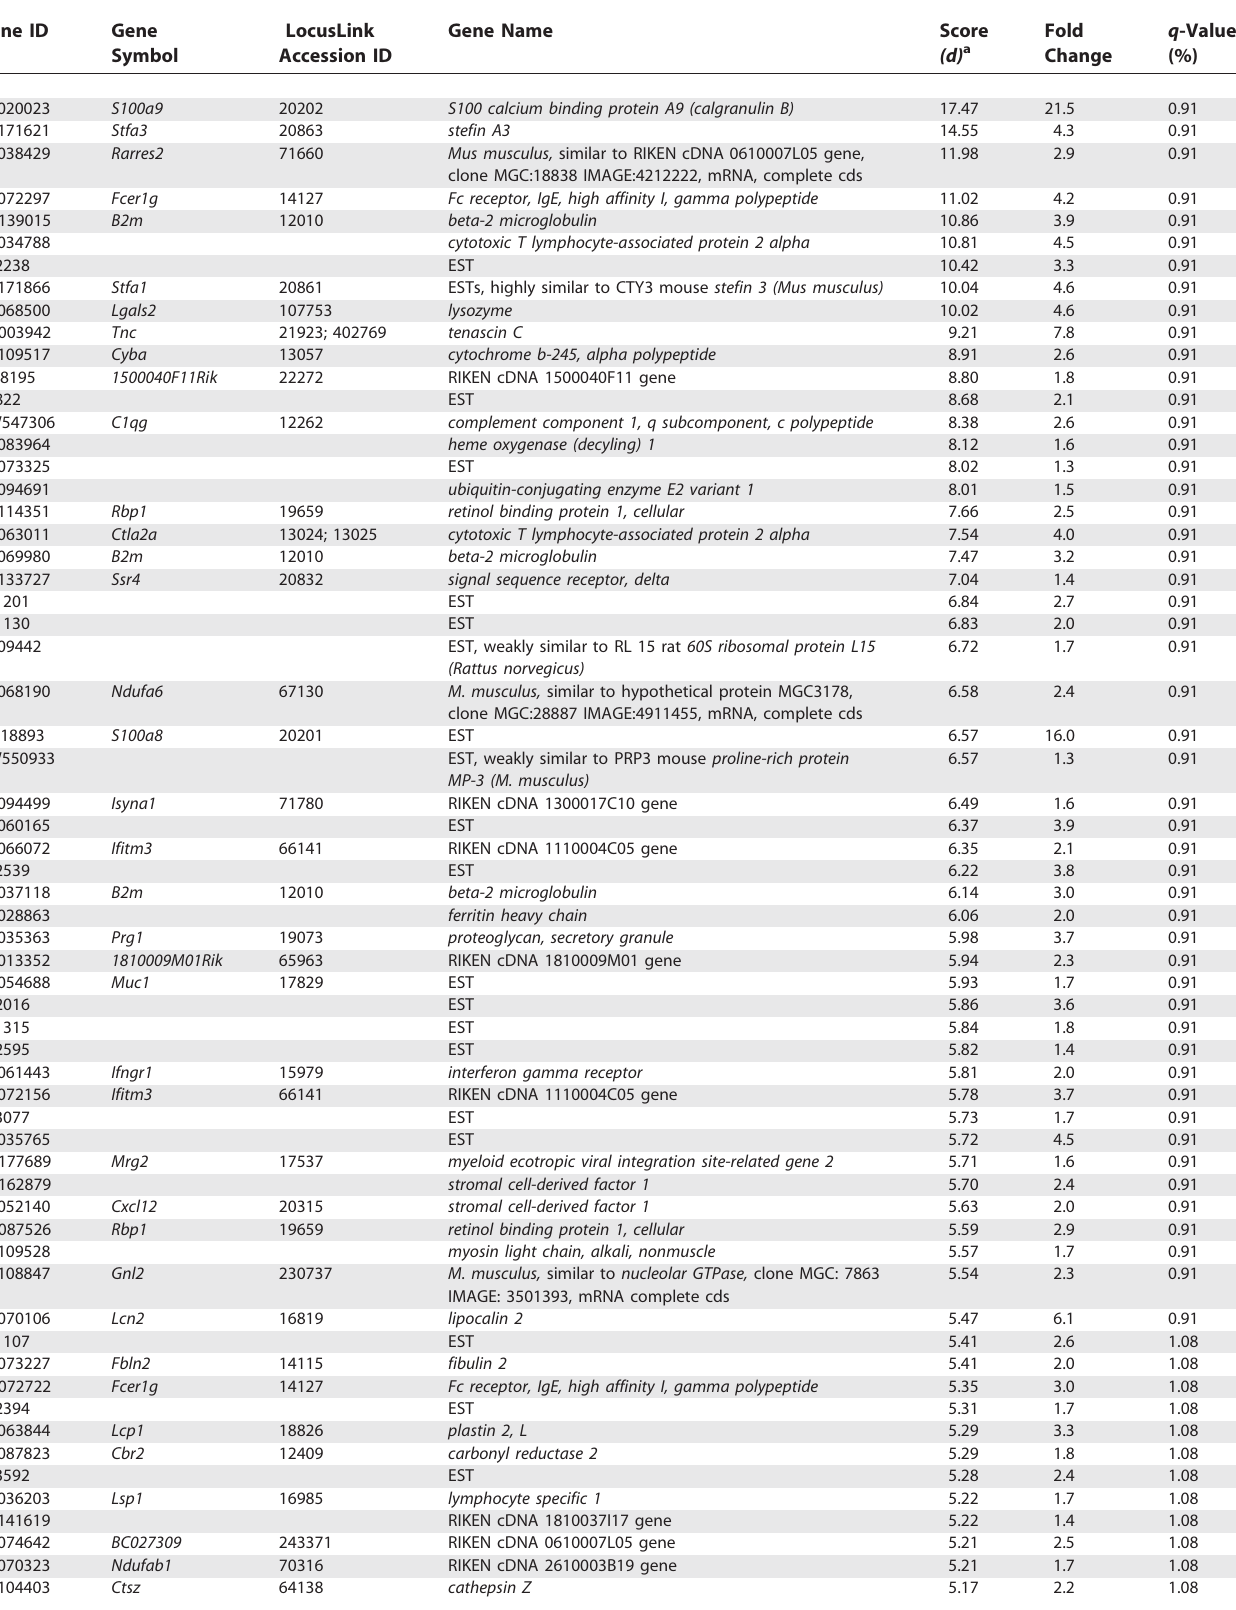
Table 3. Upregulated Genes in Lymphedema versus Normal Control (SAM, FDR , 0.05) Gene